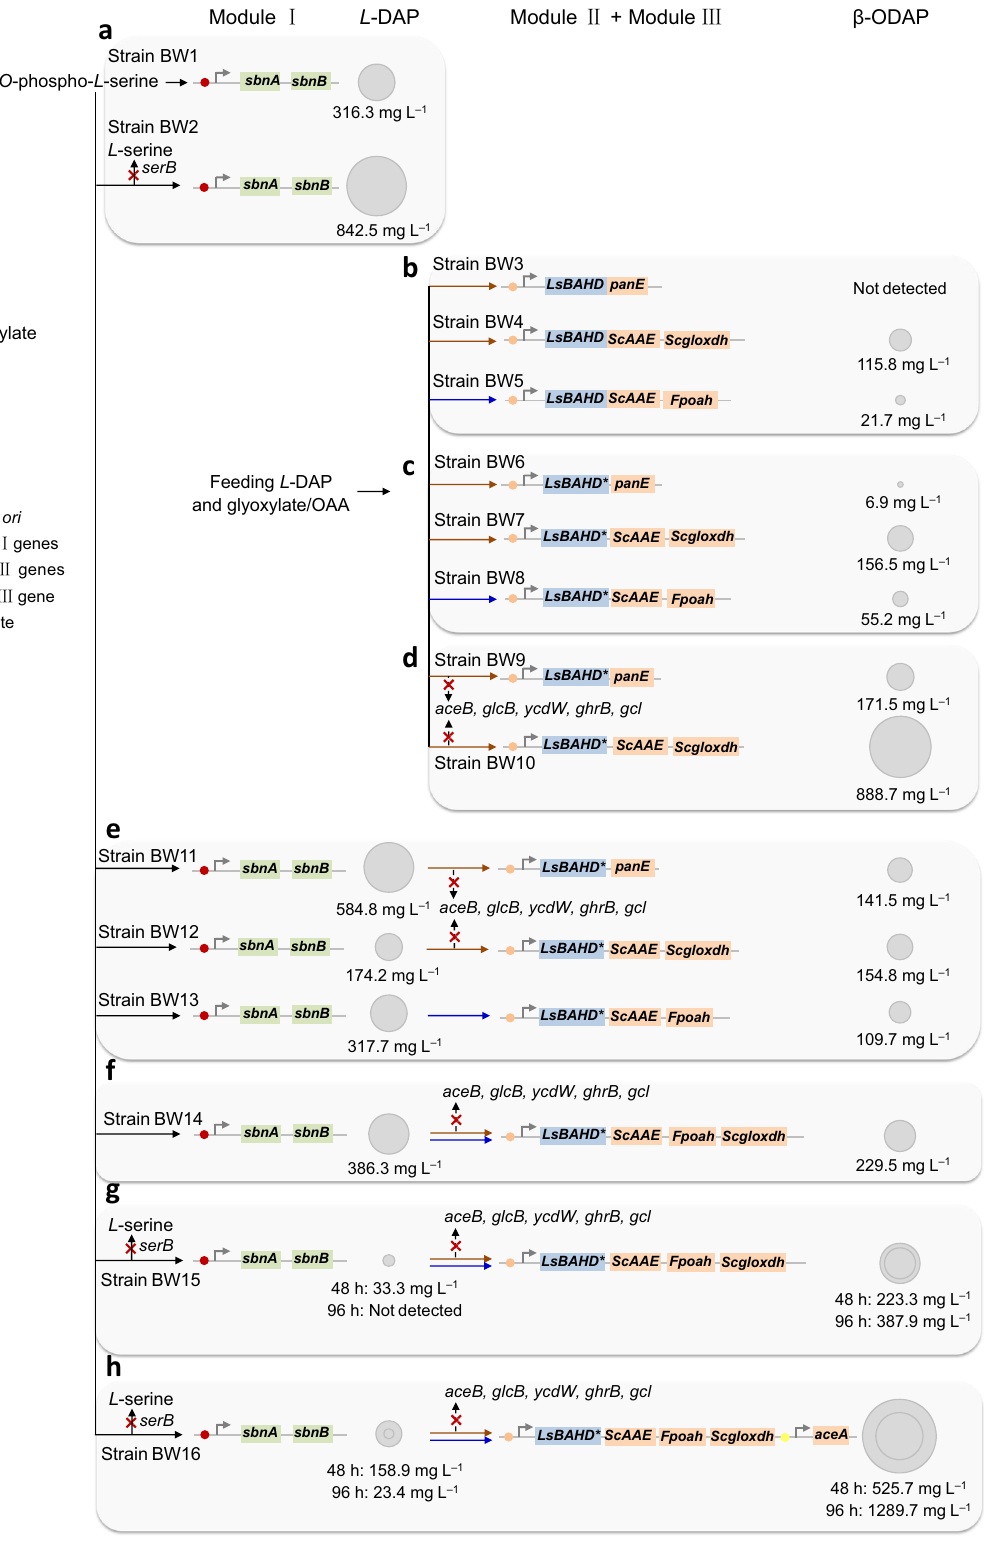
Fig. 2 | Schematic of engineering strategies to optimize β -ODAP production in E. coli . a Optimization of L -DAP production (Module I). b Comparison of the ef fi - ciencyofdifferentcombinationsinoxalyl-CoA(ModuleII)and β -ODAP(ModuleIII) biosynthesis by feeding experiments. c Enhancing β -ODAP production by improving LsBAHD solubility. d Enhancing β -ODAP production by deleting glyox- ylate degradationpathways( aceB , glcB , ycdW , ghrB , gcl ). e De novo biosynthesisof β -ODAP by three different arti fi cial pathways. f Enhancing β -ODAP production by